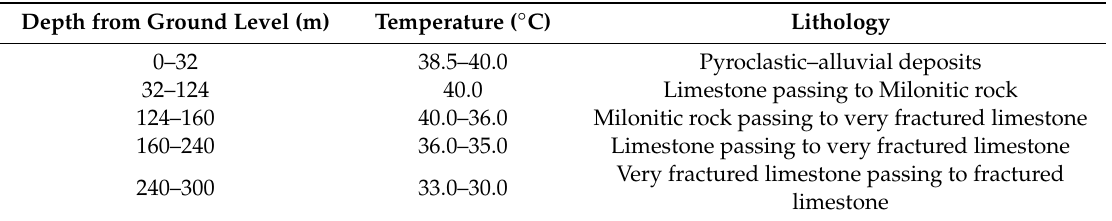
Table 3. Temperatures and lithology of the geothermal exploration well at di ff erent